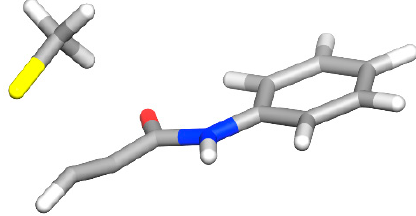
Figure 2. The energetically most favored transition state found in this study. The relevant LUMO orbitals are shown in Figure S2. orbitals are shown in Figure